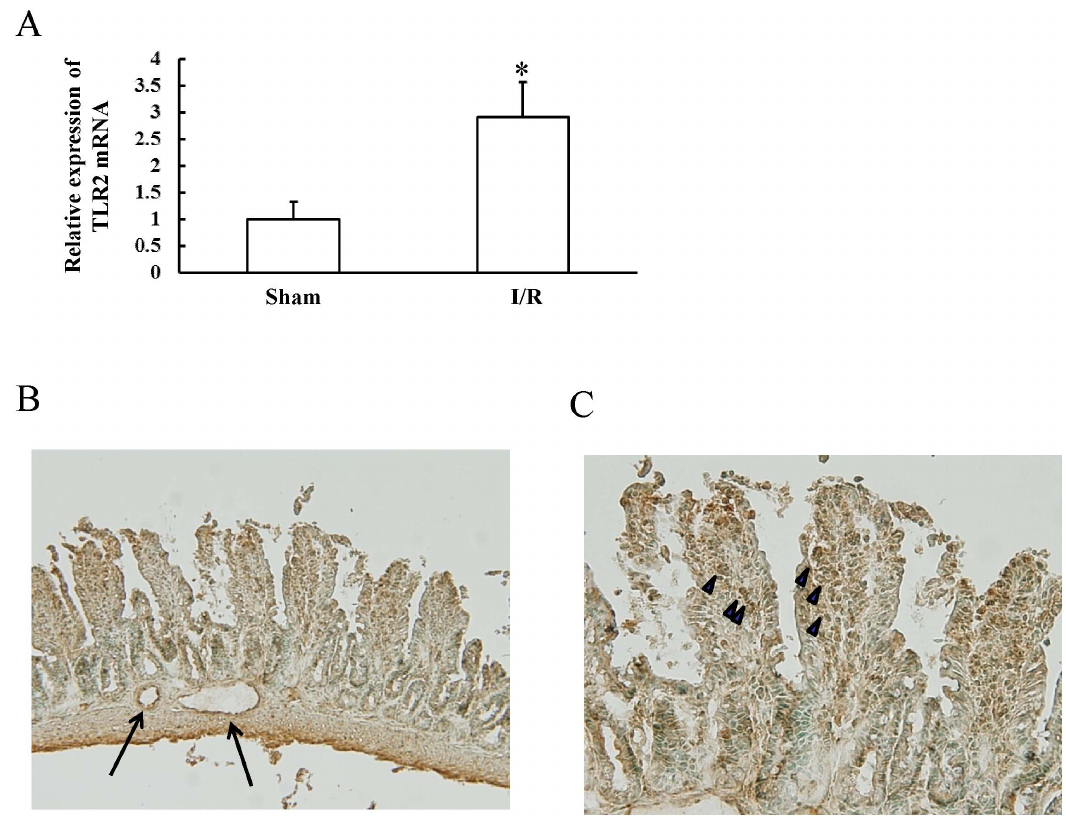
Figure 4. Expression of TLR2 during the development of the intestinal ischemia-reperfusion injury. Wild-type mice were subjected to 45 min of ischemia followed by 60 min of reperfusion. After removal of the small intestine, expression of TLR2 was examined by real-time RT-PCR and immunohistochemical staining. (A) Effect of the ischemia/reperfusion (I/R) treatment on intestinal TLR2 mRNA. Each column represents the mean 6 SD. N=6. * P , 0.01 vs mice with sham operation. (B, C) Immunohistochemical staining for TLR2. TLR2 proteins were expressed in epithelial cells, inflammatory cells (arrow heads), and endothelial cells (arrows) in the injured small intestine.